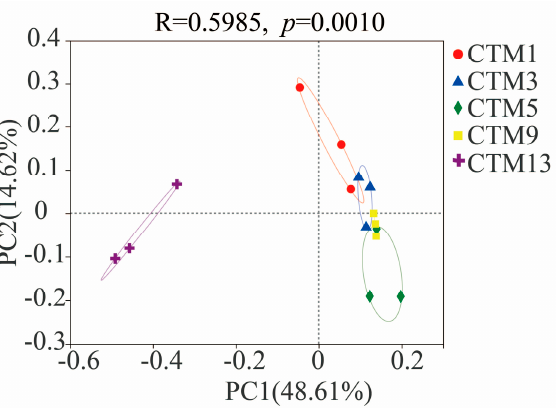
Figure 2. Principle coordinates analysis (PCoA) and ANOSIM analysis of soil fungal community composition at the OTU level with Bray–Curtis distance matrices among different CTM cycles.